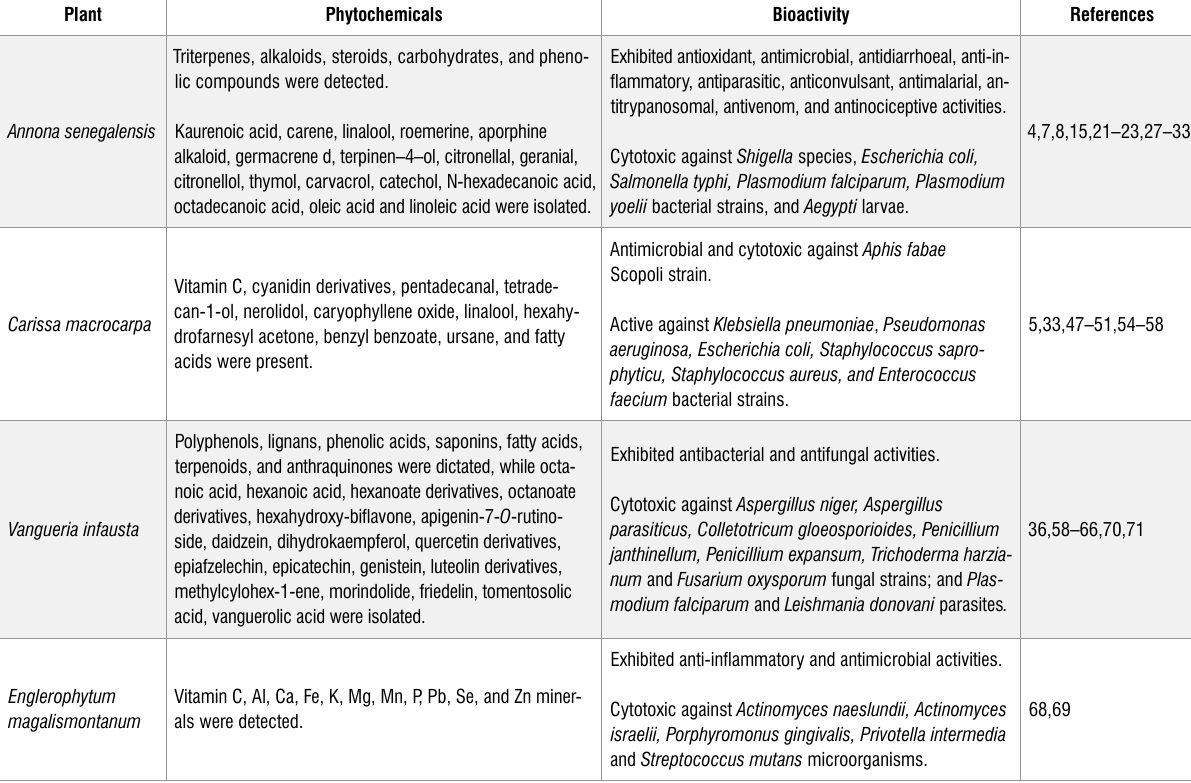
Table 2: Phytochemical profiles and bioactivity potentials of the plants under review Plant Phytochemicals